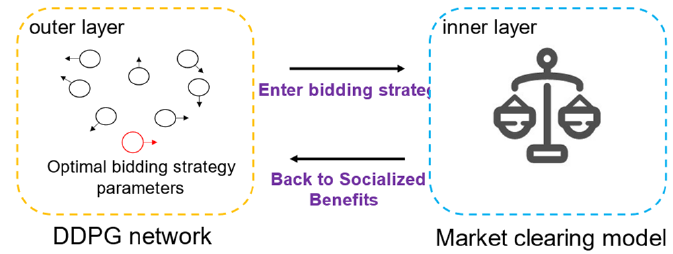
Figure 4. The two-layer structure of the algorithm.